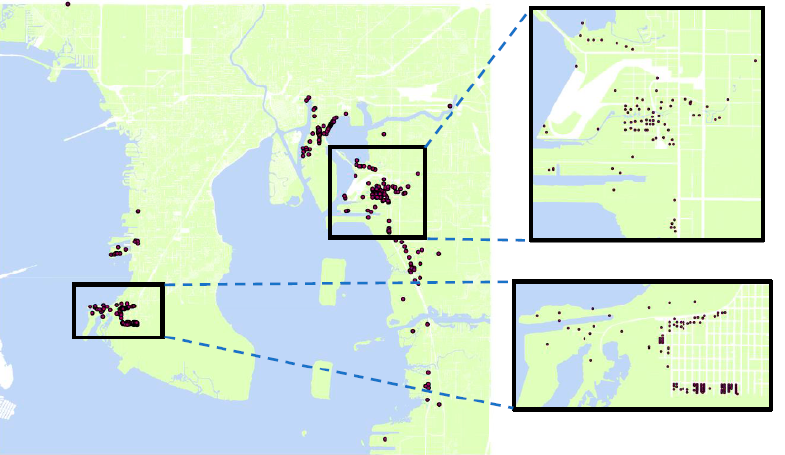
Figure 6. Flooded commercial properties by 2150 in the high-end warming scenario. The most two flooded areas are detailed in the right two subfigures. Each black dot denotes one property to be flooded due to sea level rise.